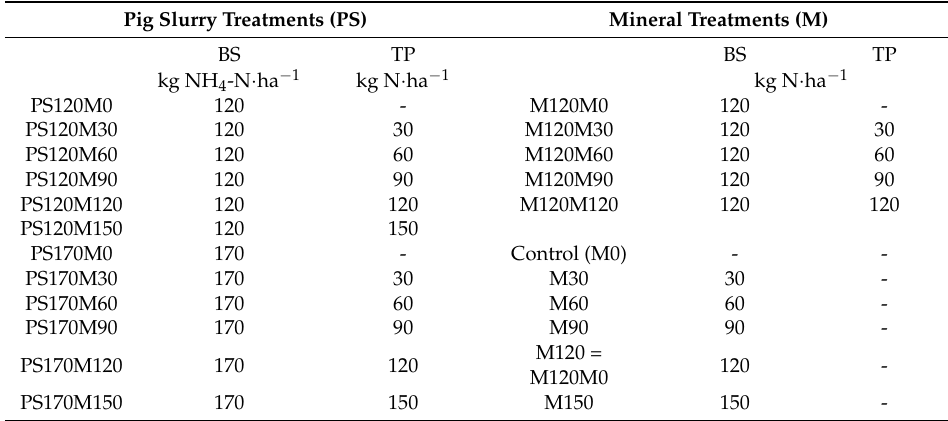
Table 1. Amounts of N applied (kg N ha − 1 ) before seeding (BS) and topdressing (TS) in the different treatments. For the PS treatments, amount indicates target N